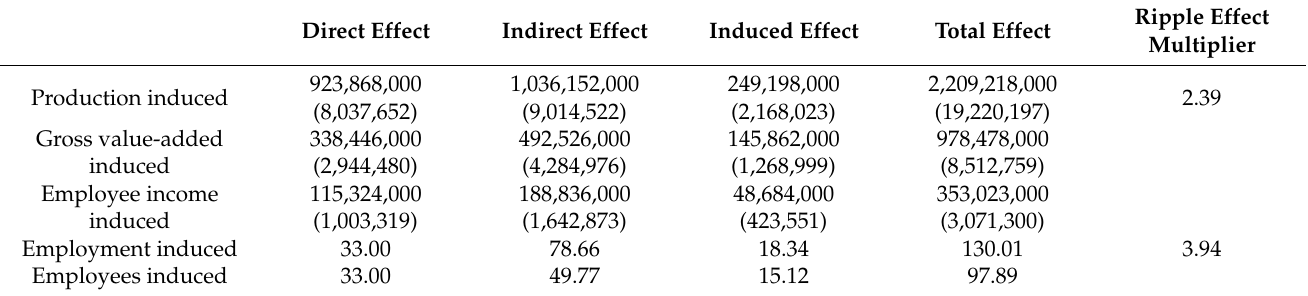
Table 7. Economic ripple effects of the GLT sector (after unifying three sectors’ self-sufficiency; unit: JPY (USD),